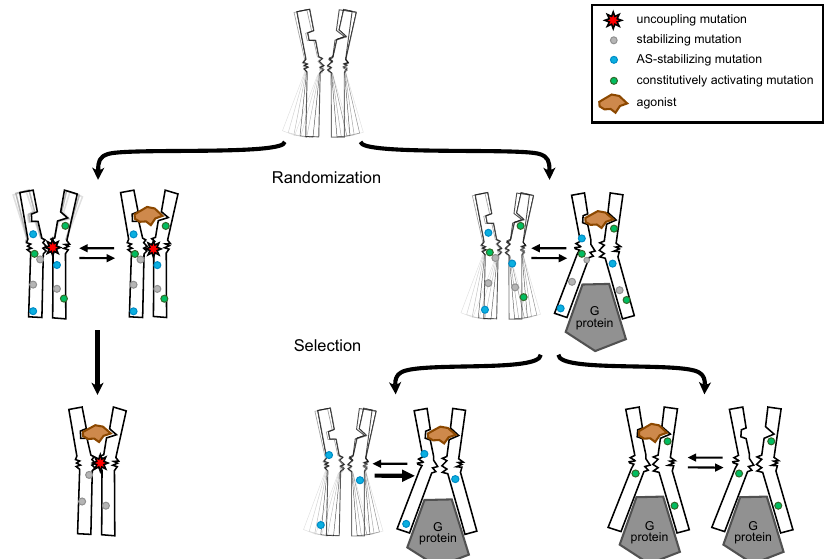
Fig. 5 | Modulation of biophysical and allosteric properties of GPCRs by directed evolution in mammalian cells. GPCRs sample a multitude of con- formational states that are allosterically modulated by ligand and G protein bind- ing. Introduction of an uncoupling mutation (red star) leads to disruption of the signal transmission from the ligand binding pocket to the G protein interface (left path). Thus, in subsequent directed evolution in the absence of G protein or when its binding was prevented by a mutation already stabilizing the inactive state, preferentially mutations that further stabilize the receptor in an inactive state